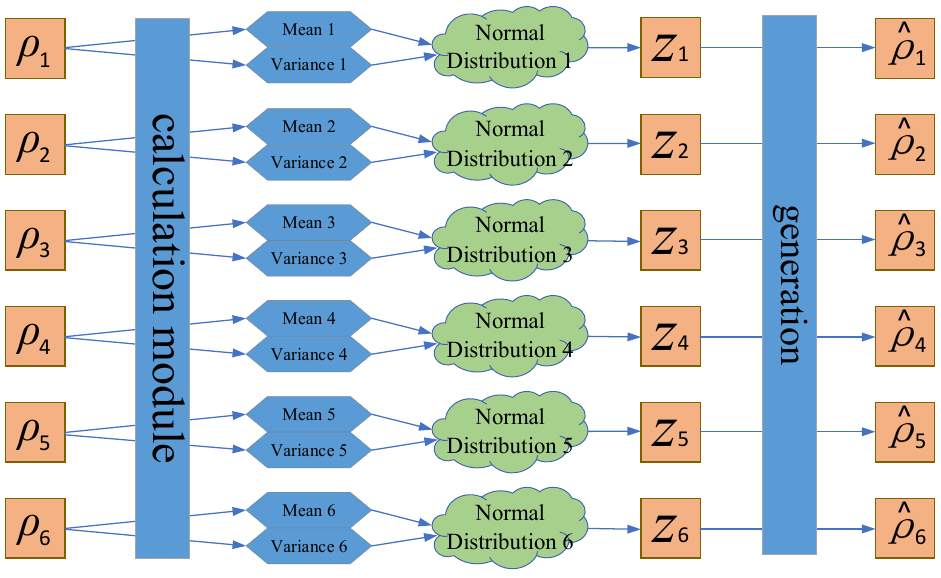
Figure 2. Structure of variational autoencoder.